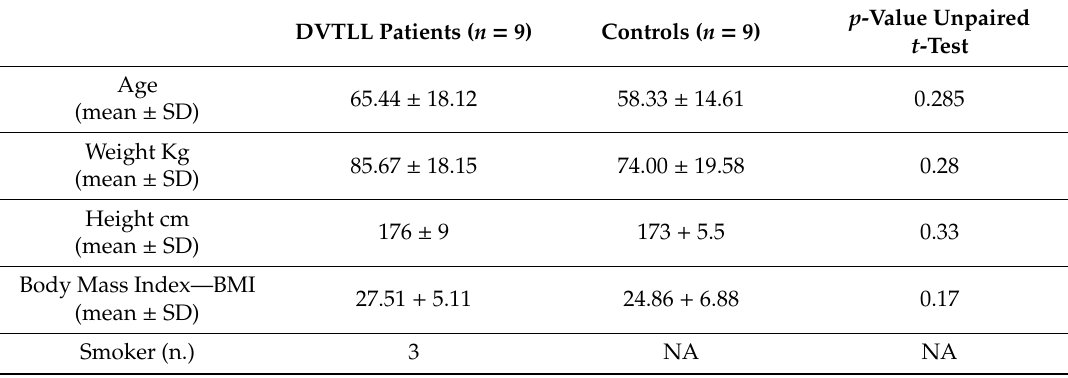
Table 1. Characteristics of deep vein thrombosis of lower limbs (DVTLL) patients and control subjects